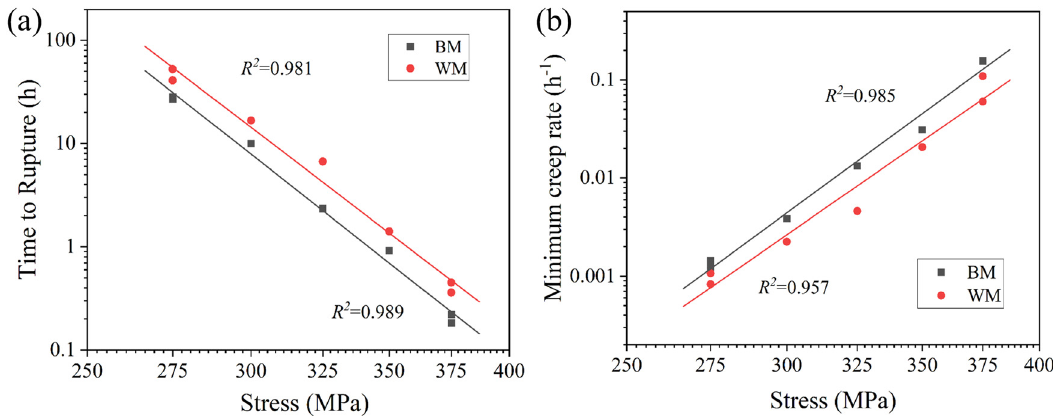
Figure 7: Variation of ( a ) time to rupture and ( b ) minimum strain rate with respect to applied stress for BM and WM specimens.